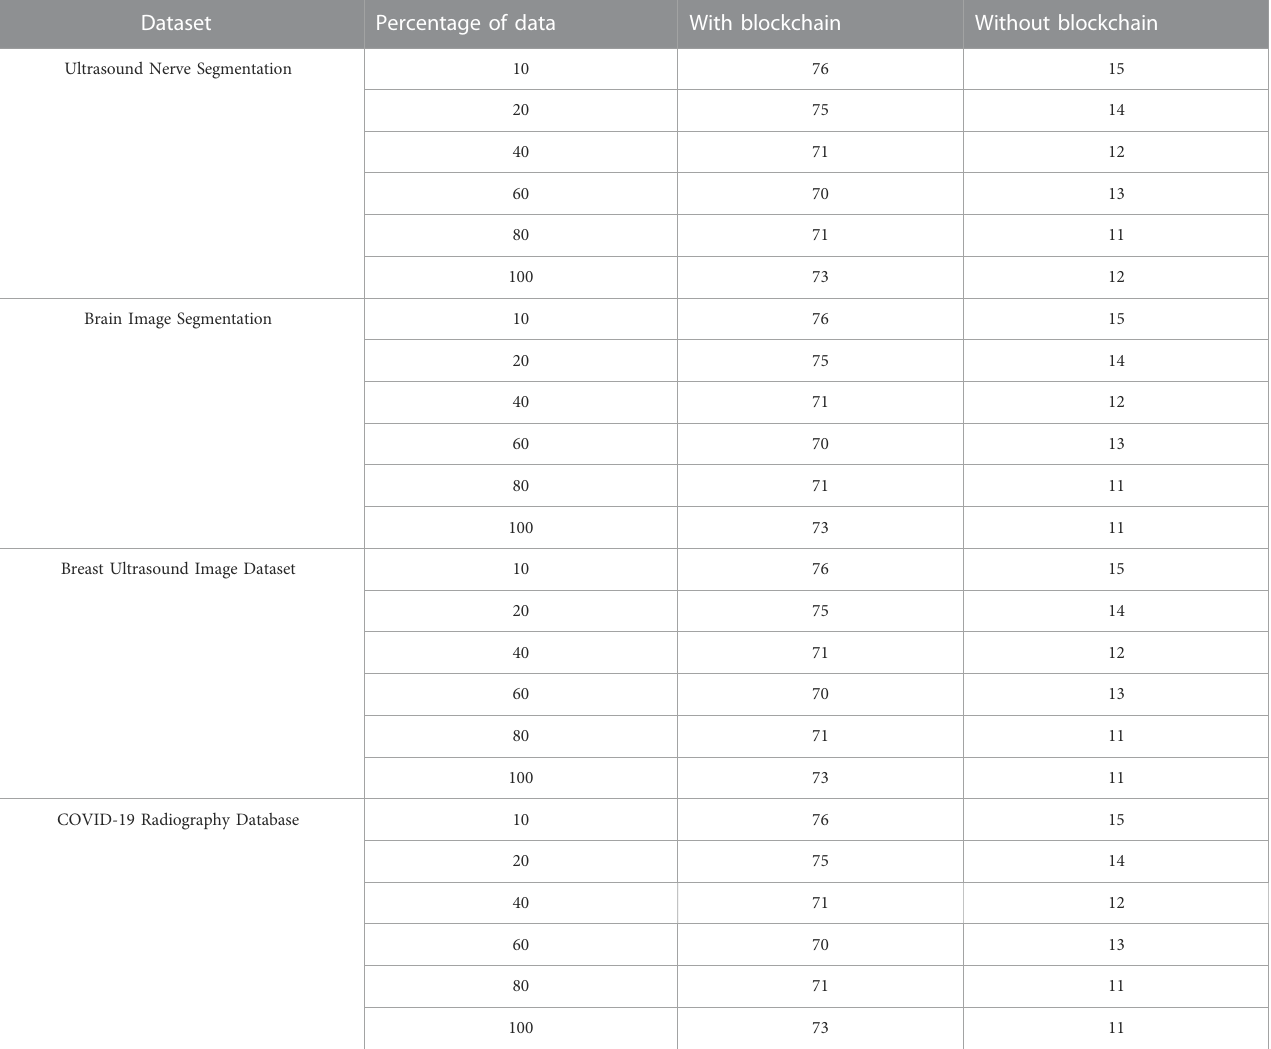
TABLE 1 Percentage of detected attacks with and without using the blockchain